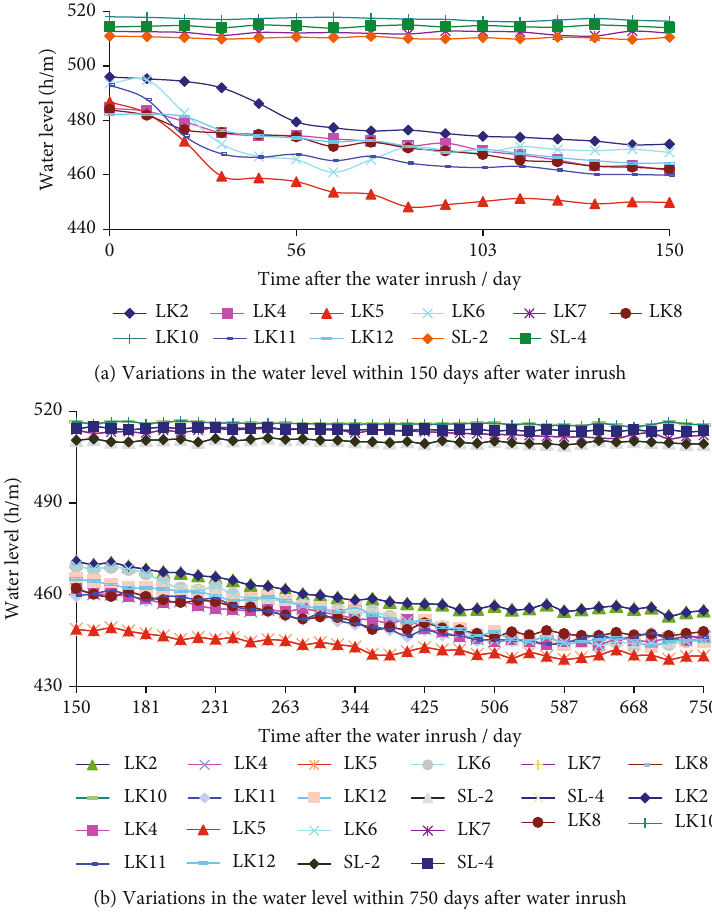
Figure 6: Variations in the water level at the observation holes with respect to